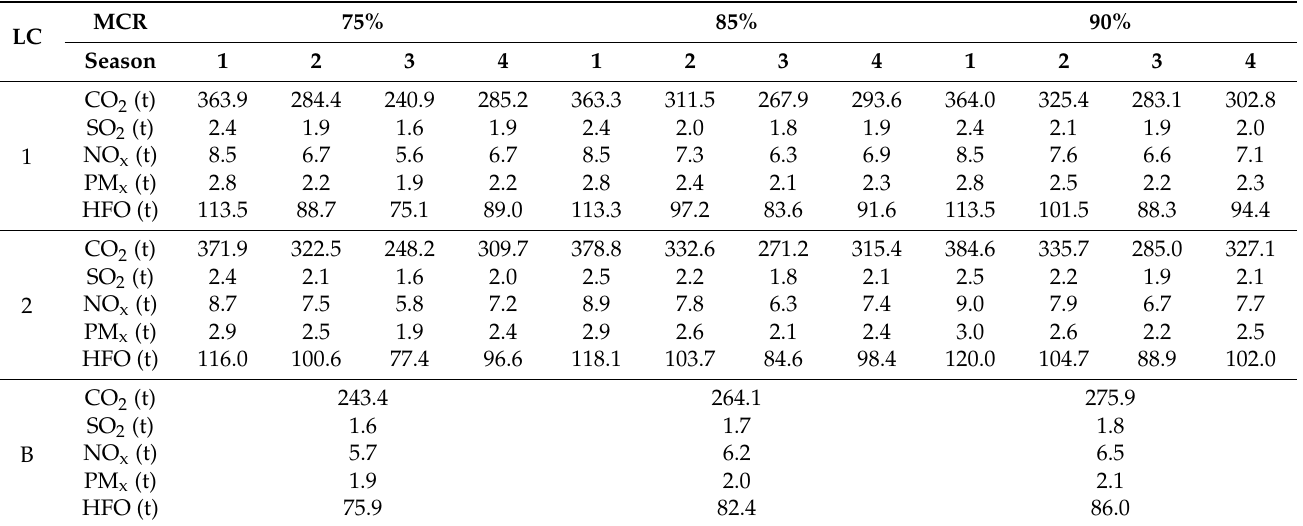
Table 9. Pollutant emissions and heavy fuel oil (HFO) consumption per season, per Load Condition and, per MCR considered in a